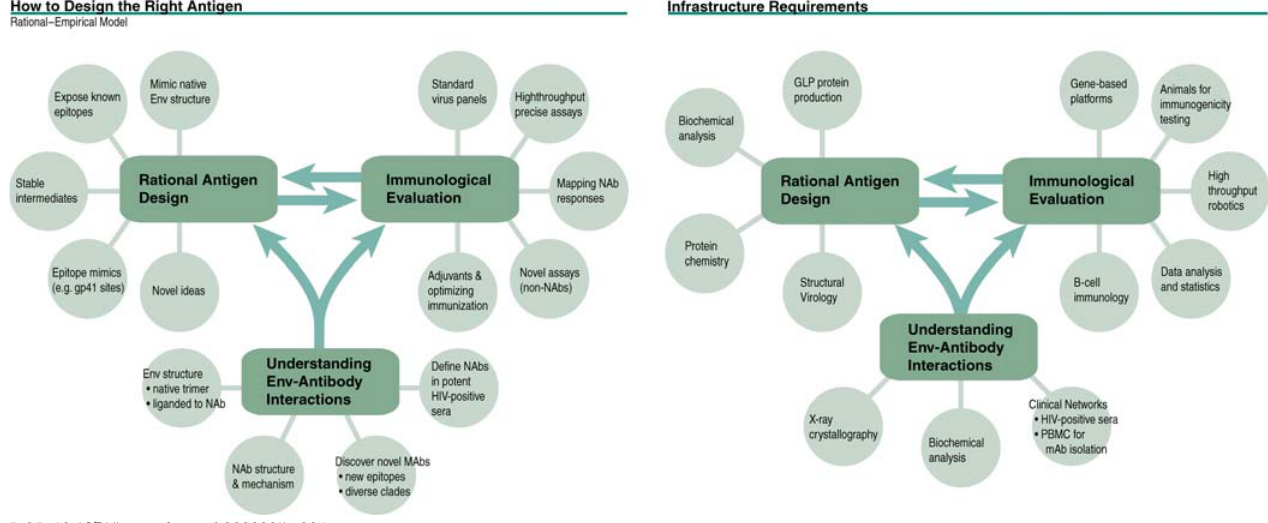
DOI: 10.1371/journal.pmed.0020025.g004 Figure 4. A Possible Model to Address Key Scientific Questions through an Appropriate Organizational Infrastructure (Courtesy of John Mascola; illustration: Giovanni Maki)